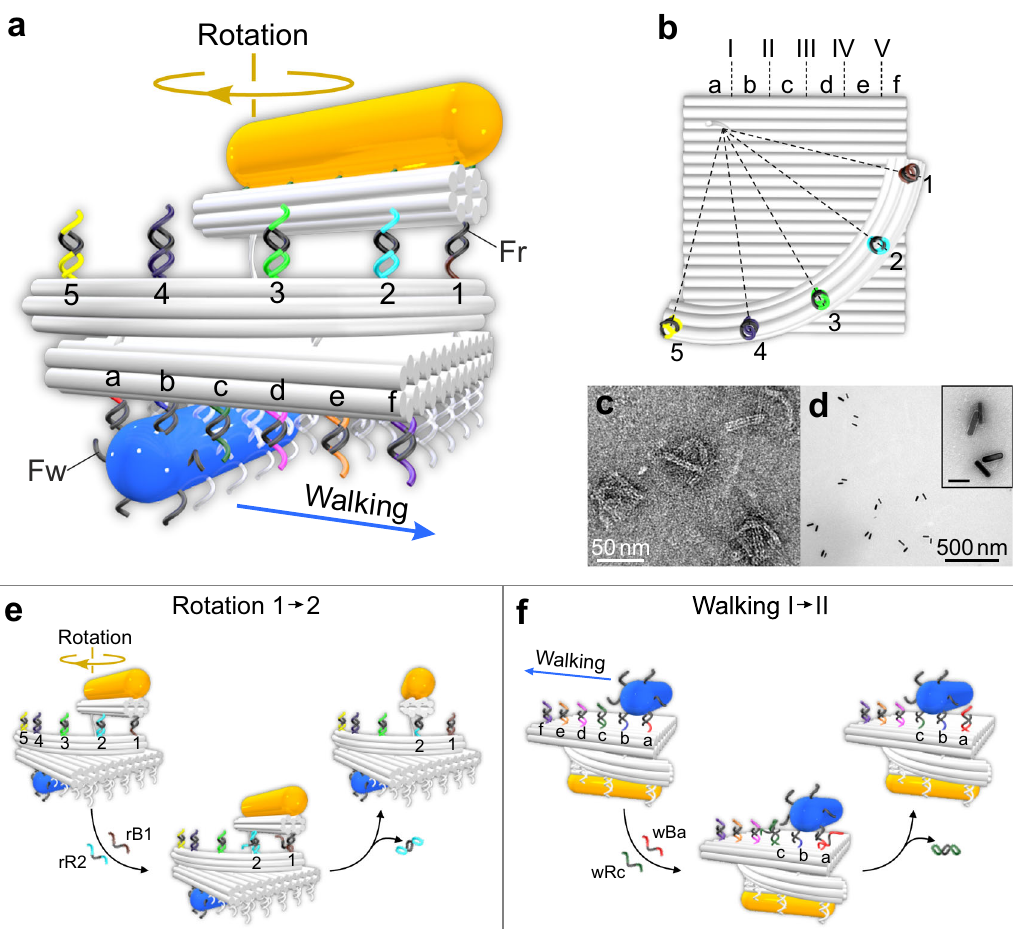
Fig. 1 UNIT with rotary and walking modules. a Schematic of the UNIT. The DNA origami template consists of a double-layer plate, a 6-helix 90° arc- shaped track, and a 10-helix rotary bundle. The rotary module contains a AuNR (yellow) anchored on the rotary bundle and the arc-shaped track dressed with fi ve rotation footholds (rfhs, rfh1 – rfh5). A foot strand (Fr) is extended from one end of the rotary bundle. The walking module contains a AuNR (blue) fully decorated with foot strands for walking (Fw) and six rows of walking footholds (wfhs, wfha – wfhf). b Top view of the rotary (positions 1 – 5) and walking (positions I – V) tracks. TEM images of the DNA origami template structures ( c ) and UNITs ( d ). Inset: enlarged view of the representative UNIT structures. Scale bar: 50 nm. e Working principle of one-step rotation from position 1 to 2. f Working principle of one-step walking from position I to II. Both the stepwise rotation and walking processes are enabled by the addition of corresponding blocking and removal strands through toehold-mediated strand displacement